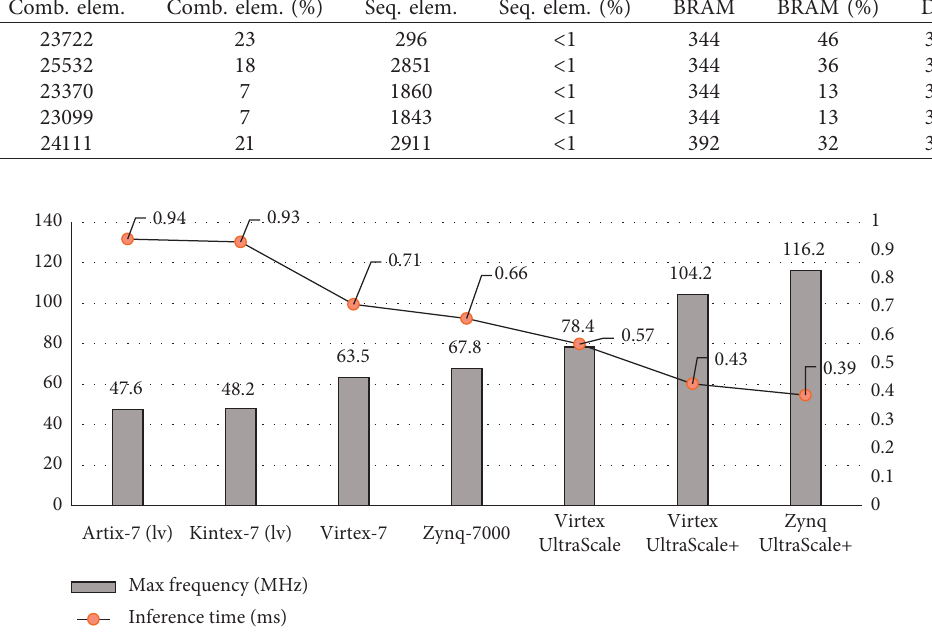
Figure 8: Maximum clock frequency and inference time for different Xilinx FPGA families.